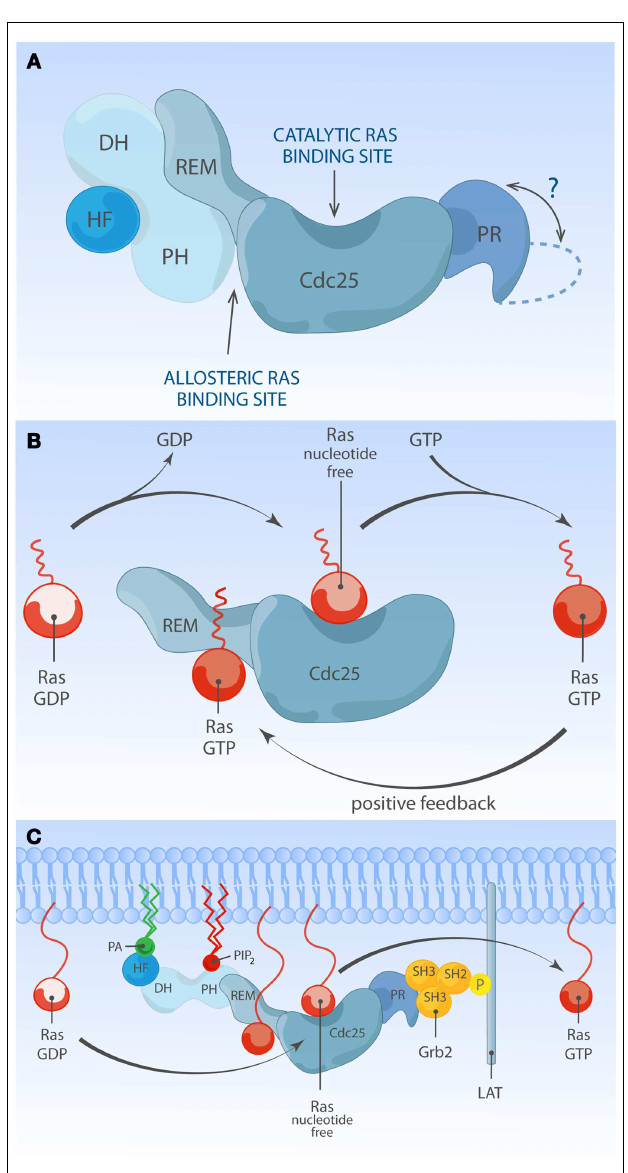
FIGURE 3 | Multiple membrane-derived signals determine the RasGEF activity of SOS. (A) Model of inactive SOS. In the inactive state, SOS’s DH-PH domains obscure the allosteric Ras-binding pocket.Without engagement of the allosteric pocket by Ras · GTP, SOS only shows low reactivity for Ras · GDP at the catalytic binding site.The HF docks itself to a helical linker region (not depicted) between PH and REM domains, further stabilizing auto-inhibited state of SOS.The protein structure of the C-terminal proline-rich domain has not been determined to date. (B) Model of allosteric activation of SOS. Ras · GTP binding to the allosteric site enhances SOS exchange activity by increasing Ras-binding affinity for the catalytic pocket, establishing a positive feedback mechanism. Other SOS domains are omitted for simplicity. (C) Model of full activation of SOS. Full activation of SOS requires the integration of multiple membrane-derived signals. Grb2-mediated membrane recruitment of SOS to phosphorylated LAT is thought to be one of the initial membrane recruitment mechanisms. Membrane phospholipids such as PIP 2 and PA interact with HF and PH domains, and these interactions further relieve auto-inhibition state of SOS, allowing efficient access of Ras to both the allosteric and catalytic